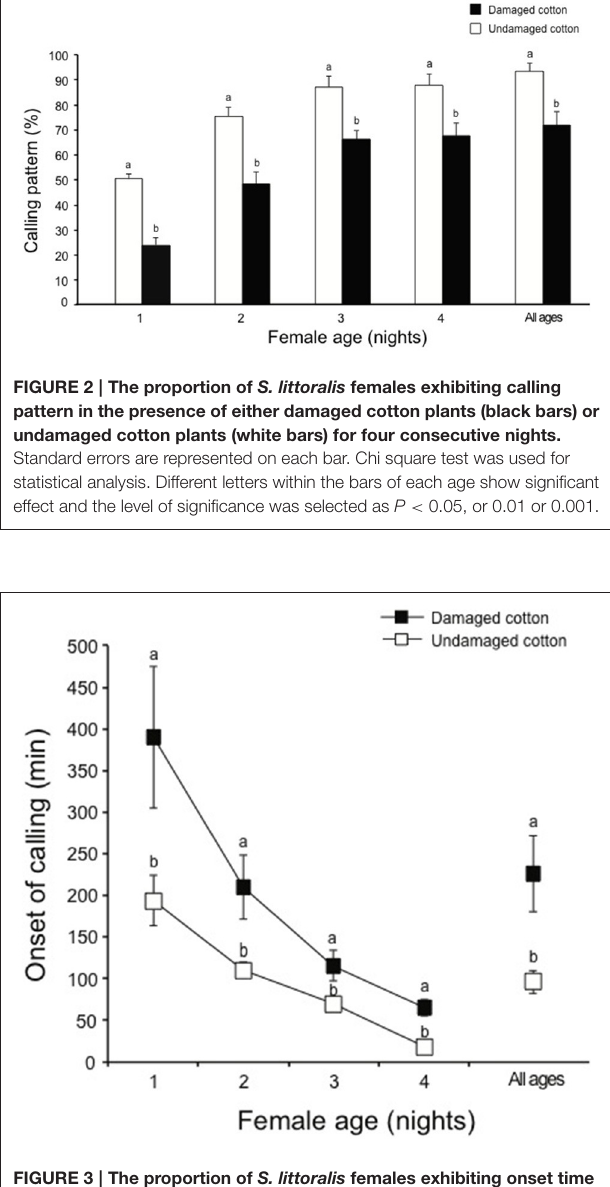
FIGURE 3 | The proportion of S. littoralis females exhibiting onset time of calling in the presence of either damaged cotton plants (black boxes) or undamaged cotton plants (white boxes) for four consecutive nights. Standard errors are represented on each box. Chi square test was used for statistical analysis. Different letters within the bars of each age show significant effect and the level of significance was selected as P < 0.05, or 0.01 or